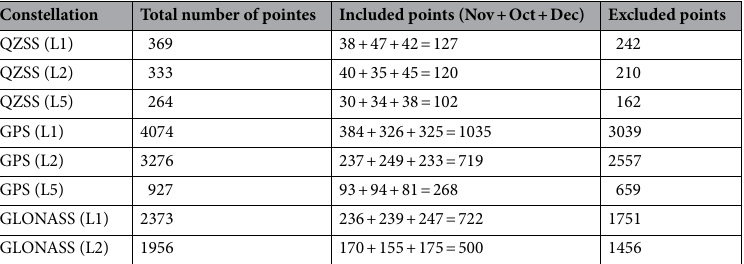
Table 1. Total number of points by different constellation, only those points which has range value 0.5 to 1.5 are included and others are excluded.